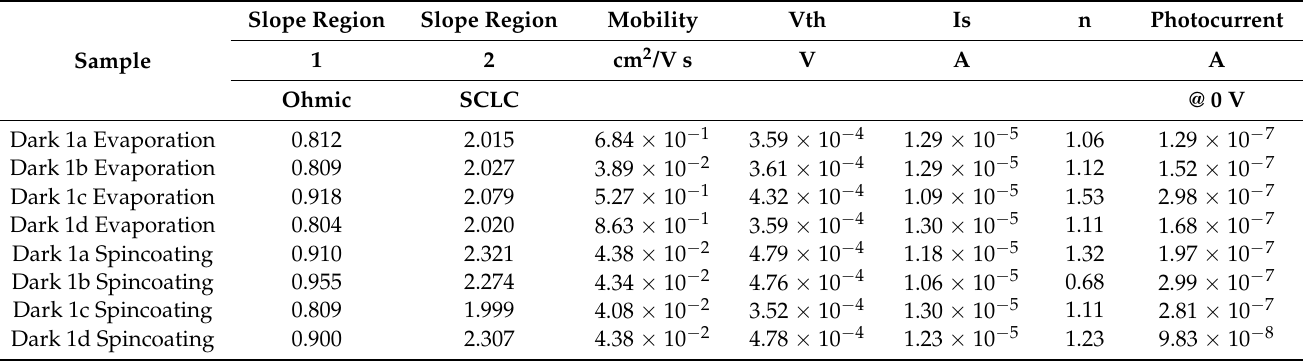
Table 2. Organotin (IV) complexes devices electrical